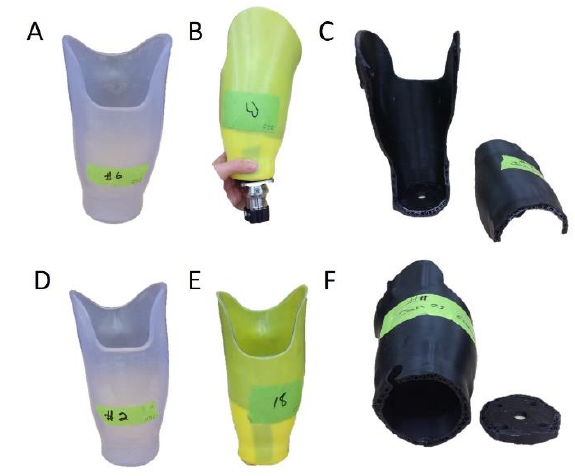
FIGURE 7. Typical failure methods for sockets made for locking liners. At Condition I: (A) thermoplastic sockets yielded and deformed, (B) all laminated composite sockets failed differently with one socket separating from the pyramid when the lock broke, and (C) all 3D Printed PLA sockets broke circumferentially at the distal end and up the sides. At Condition II: (D) thermoplastic sockets yielded and deformed and the locks broke, (E) the laminated composite sockets’ lock mechanisms broke and (F) 3D Printed PLA sockets broke circumferentially at the distal end.